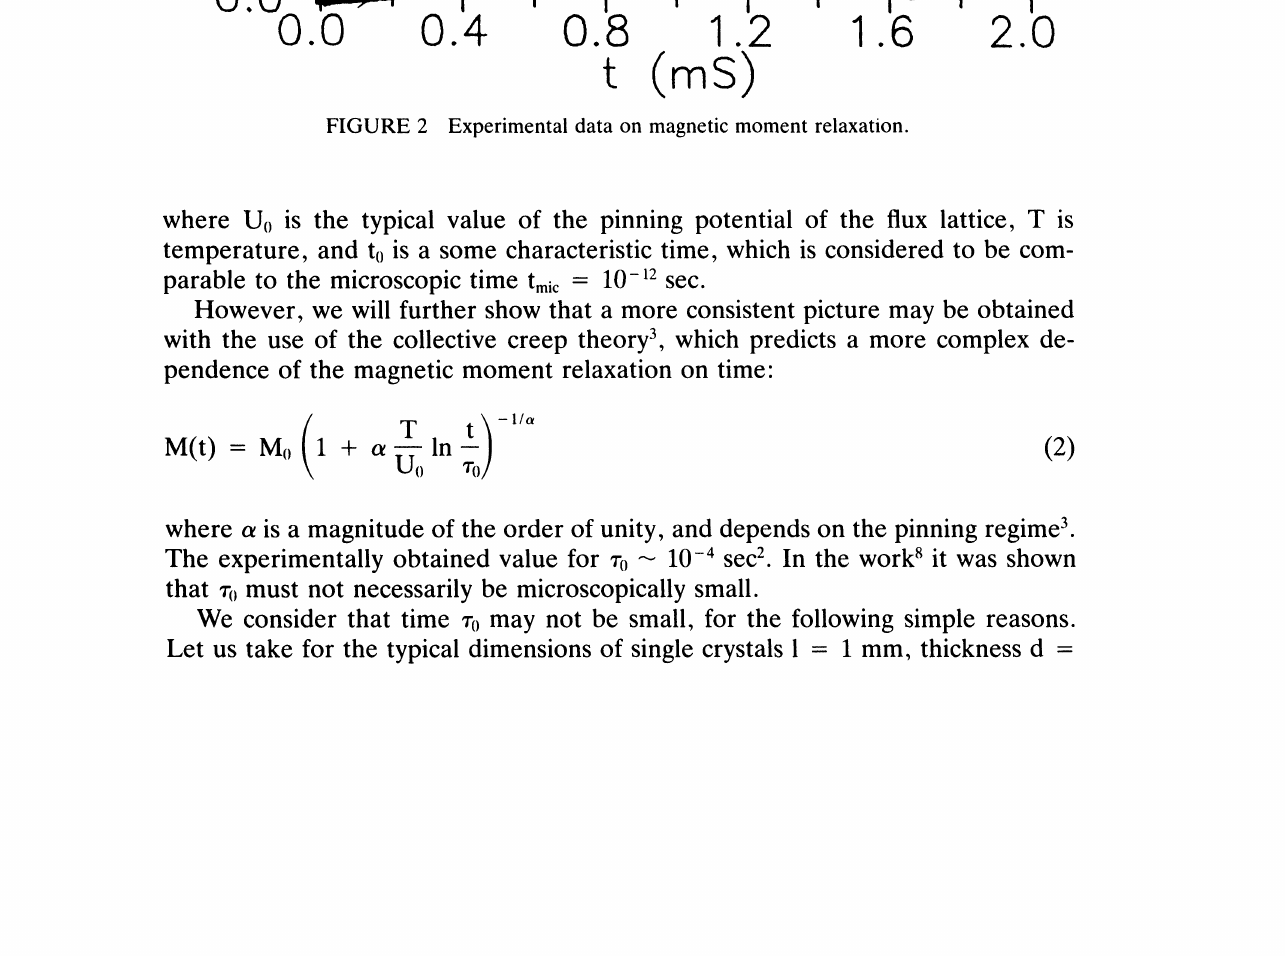
FIGURE 2 Experimental data on magnetic moment